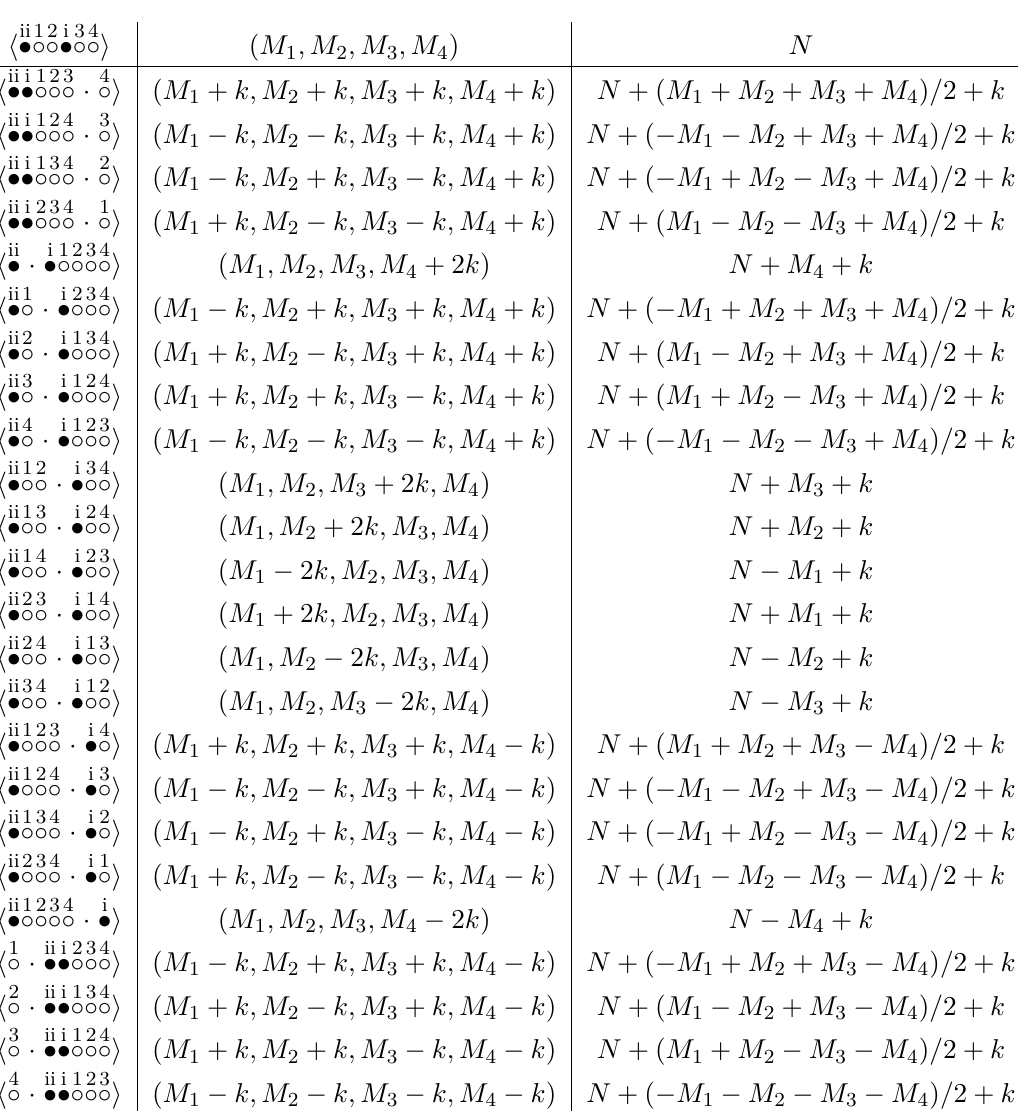
Table 6 . Changes of the relative ranks ( M 1 , M 2 , M 3 , M 4 ) and the overall rank N , for the brane configurations of the F Weyl group. Here we change references into that denoted by · in applying 4 duality